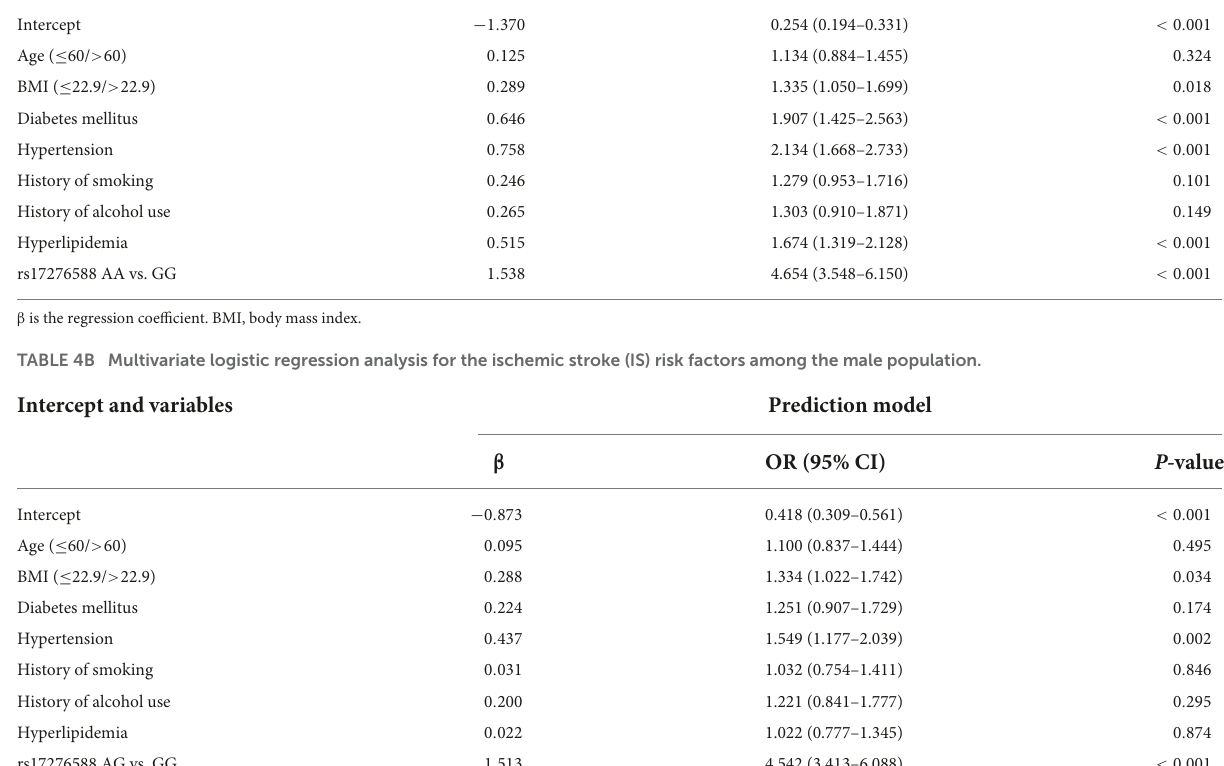
identified as independent predictors for IS ( Table 4B ). The LASSO analysis and cross-validation results illustrated that the optimal lambda ( λ ) value was 0.00140712 for the 1,394 male participants in the training cohort. The eight clinical risk factors screened in the male training cohort ( Figures 3A,B ) were identified as the best risk factors in the LASSO regression model ( Supplementary Table 3 ). On the other hand, five clinical features, including high BMI, hypertension, history of alcohol use, diabetes mellitus and rs17276588 had non-zero